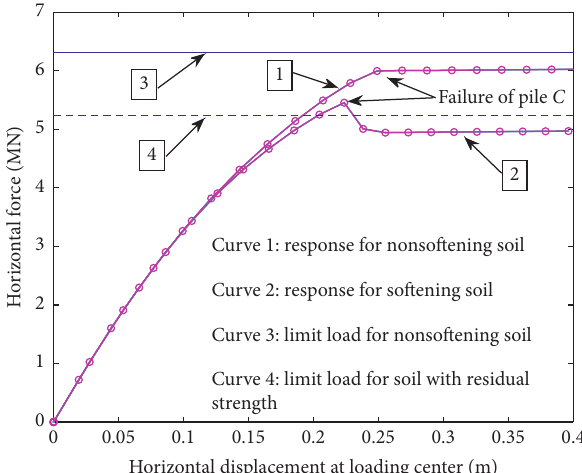
Figure 12: Pile system horizontal load-displacement curves. Figure 10: Axial load-displacement response of a single pile.